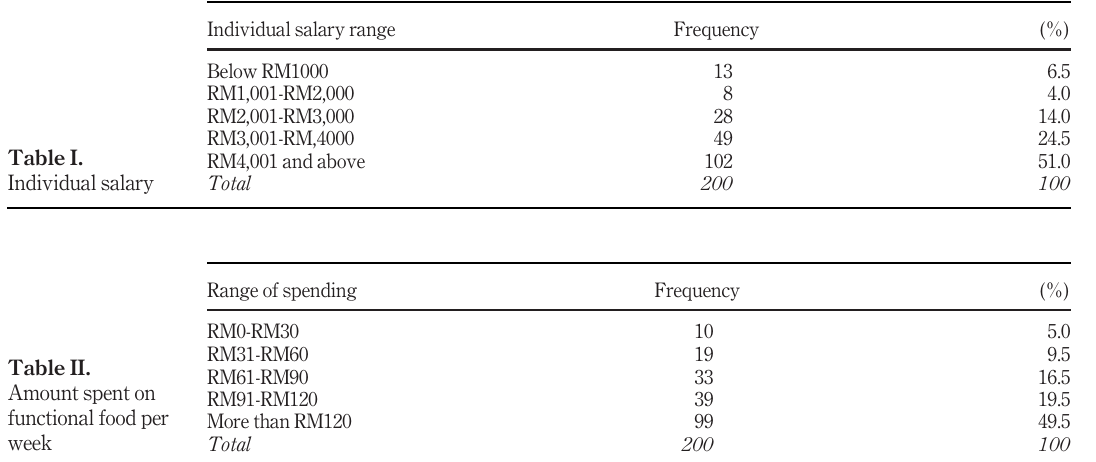
Table II. Amount spent on functional food